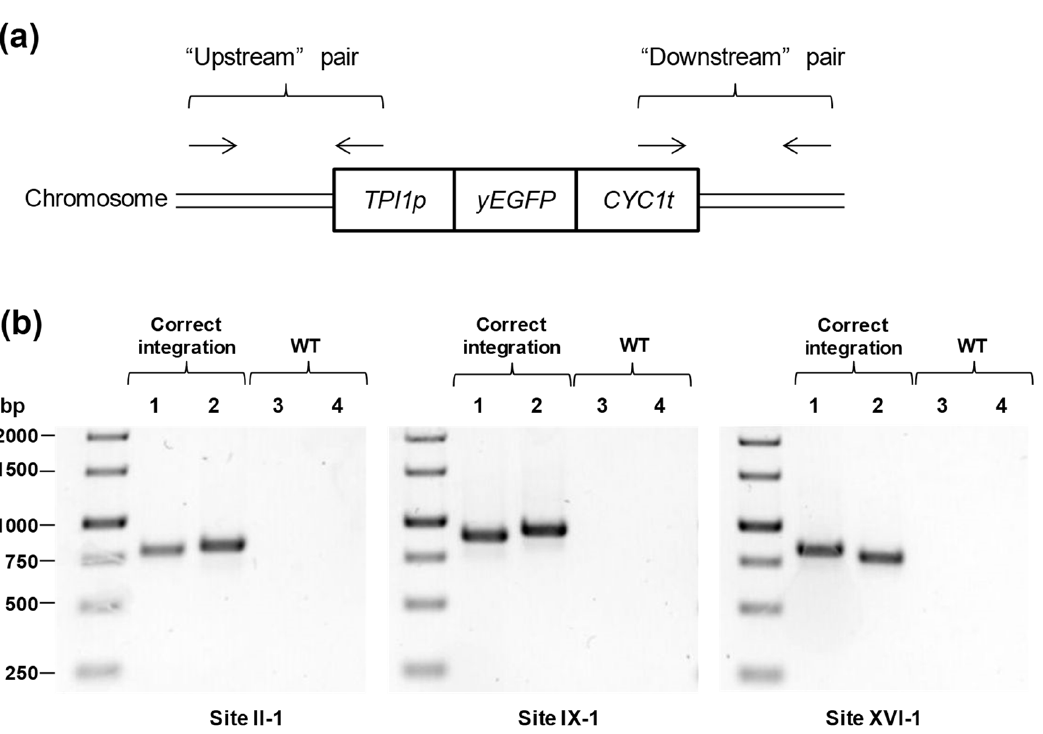
Figure 3. Verification of the integration of the cassettes into target sites. ( a ) Scheme for annealing of the primers. ( b ) Gel electrophoresis of the PCR products. 1, 3—“Upstream” primer pairs. 2, 4—“Downstream” primer pairs. WT—BY4742 cells were used as templates (the negative control).